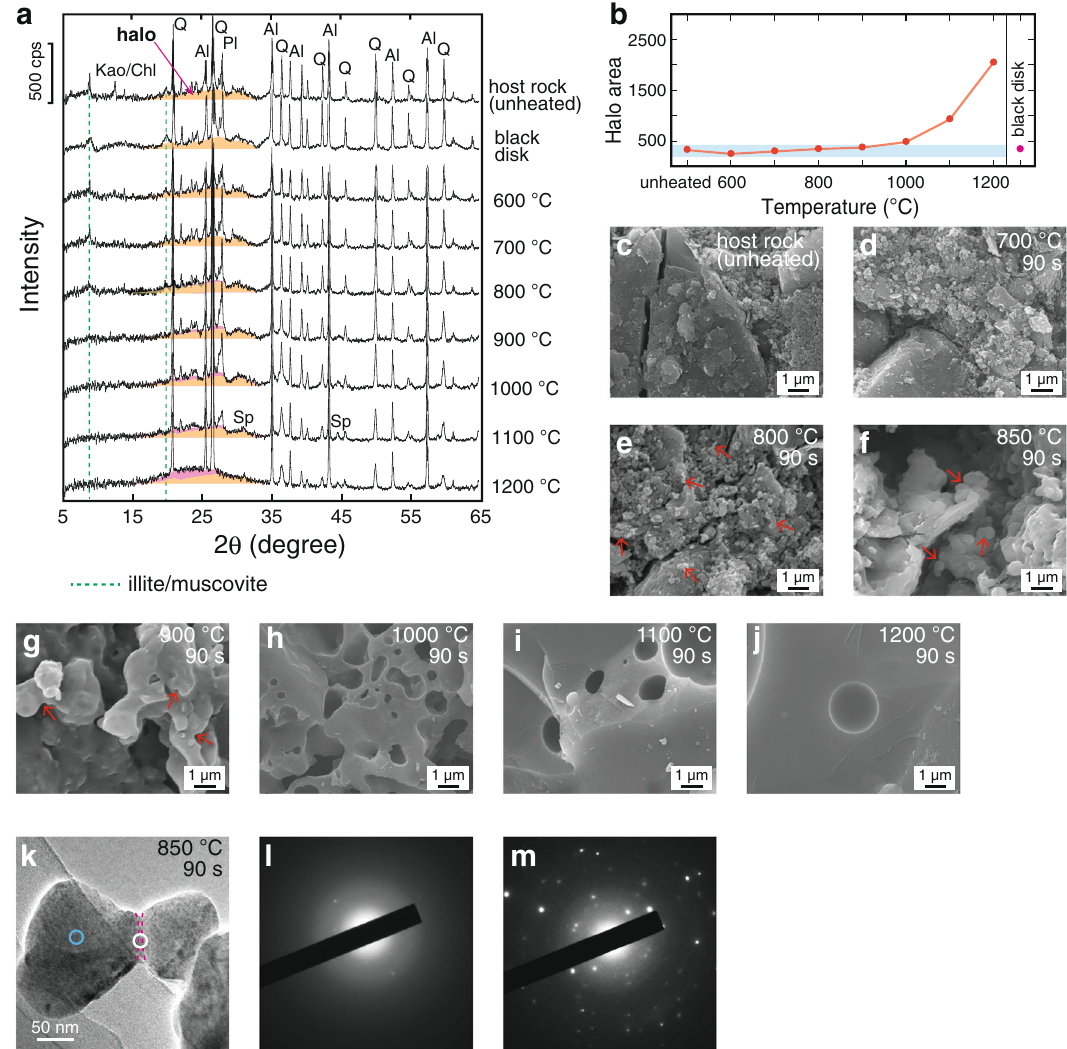
Fig. 2 Sintering at high temperature accompanied by crystallinity and microstructural changes. a X-ray diffraction patterns of samples before and after heating, and of the black disk from the Chelungpu fault. Broad, rounded peaks (halos) at ~20 – 30° 2 θ are shown by orange and pink shading, where the latter represents the increase in the area of the halo compared with the unheated sample. b Change in the halo area (intensity × 2 θ ) with temperature. The horizontal blue bar indicates the initial size of the halo, which corresponds to the initial amount of minerals with imperfect crystal lattices. SEM images of samples ( c ) before and after heating for 90 s at d 700 °C, e 800 °C, f 850 °C, g 900°C, h 1000 °C, i 1100 °C, and j 1200 °C. k Bright- fi eld transmission electron micrograph of the neck between two ultra fi ne particles and ( l ) the electron diffraction pattern (within the white circle in k ). m Diffraction pattern of an ultra fi ne particle within the blue circle in k . Red arrows in e , f , and g and area outlined by dotted red curves in k indicate representative examples of neck growth. Kao kaolinite, Chl chlorite, Q quartz, Pl plagioclase, Sp spinel, Al α